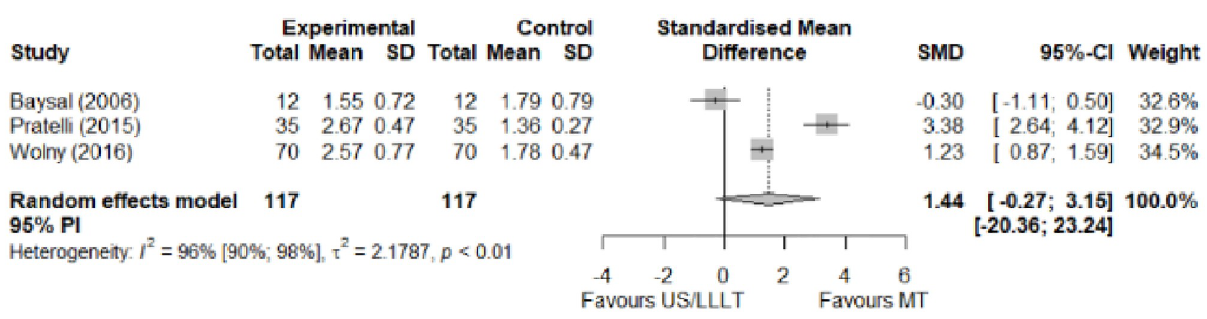
Fig 14. Analysis—Electrophysical modalities versus manual therapy (symptoms severity).